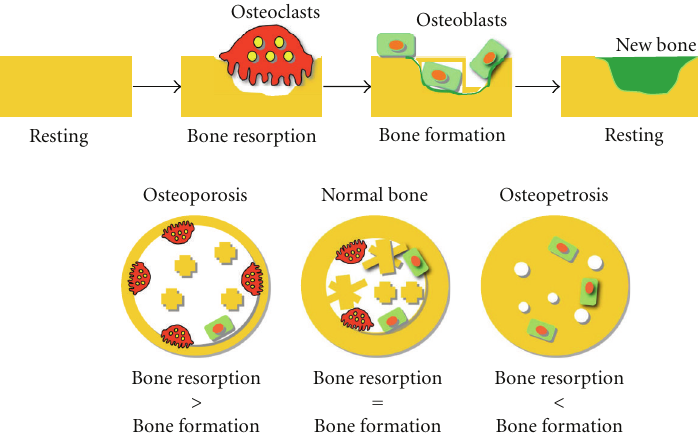
Figure 1: The schematic outlines of the bone remodeling cycle and the balance of bone resorption and bone formation.(a) In bone tissue, the osteoblasts are involved in new bone formation, while osteoclasts play a major role in bone resorption. The first step in the bone remodeling cycle is the resorption of existing bone by osteoclasts, followed by formation of the cement line in resorption lacunae and osteoblasts. Each cell type seems to be regulated by a variety of hormones and by local factors. (b) If the balance between bone formation and resorption is lost by the uncontrolled production of regulators, bone structure would be strikingly damaged, and the subject would be susceptible to osteoporosis and